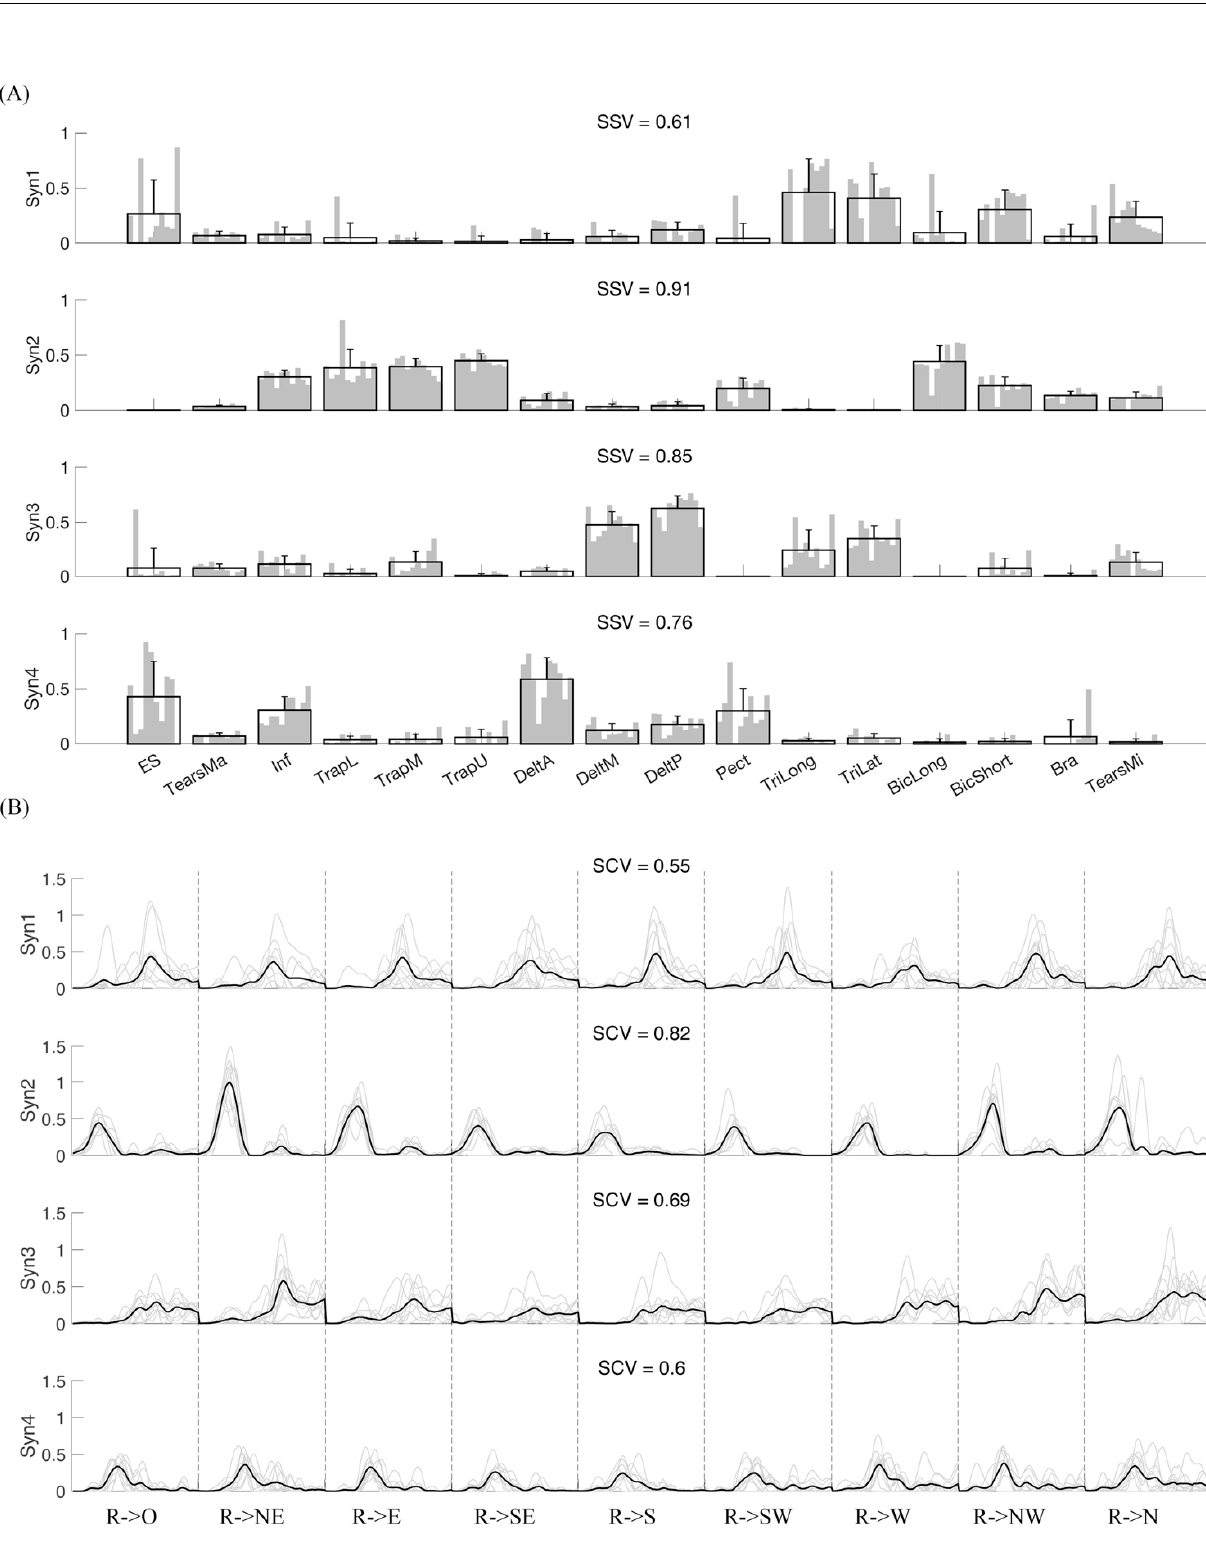
Figure 7. Intra-subject similarity analysis for a representative subject. ( A ) Synergy vectors similarity. Four synergies were extracted from each repetition, then they were matched among repetitions. Each subplot shows corresponding synergy vectors. Gray bars indicate different repetitions, and the black bar for each muscle indicates group mean and standard deviation. SSV is the average similarity of synergy vectors among repetitions. Panel ( B ) shows activation coefficients (AC) similarity. Four ACs corresponding to four synergies were extracted from each repetition. The gray line is the AC from each repetition, and the black line is the mean time course for temporal coefficients across repetitions. SCV is the mean similarity of activation coefficients across repetitions.